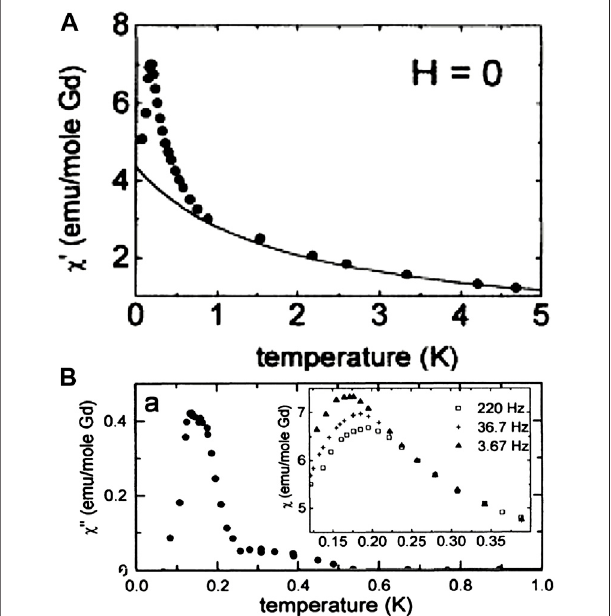
FIGURE5|(A) Thetemperaturedependence oftherealpartofthelinear susceptibility (H = 0) along with the Curie-Weiss behavior extrapolated from higher temperatures along [1 0 0], [15]. (B) The temperature dependence of the imaginary part of the linear susceptibility, χ ” (T). The inset shows the frequency dependence of χ ′ (T)